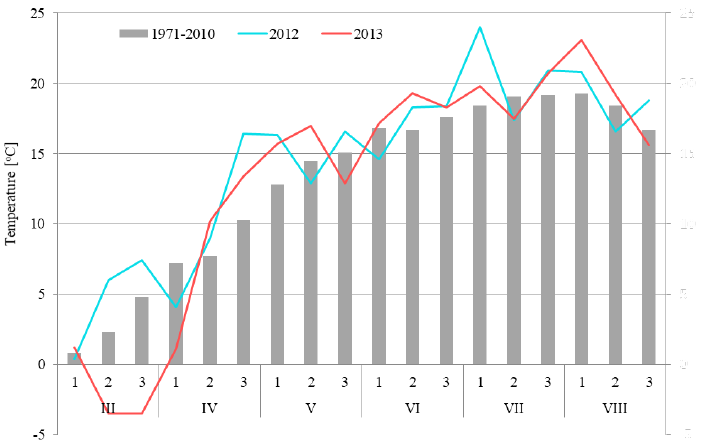
Figure 7. The average decade air temperature in year 2012–2013 and period 1971–2010.